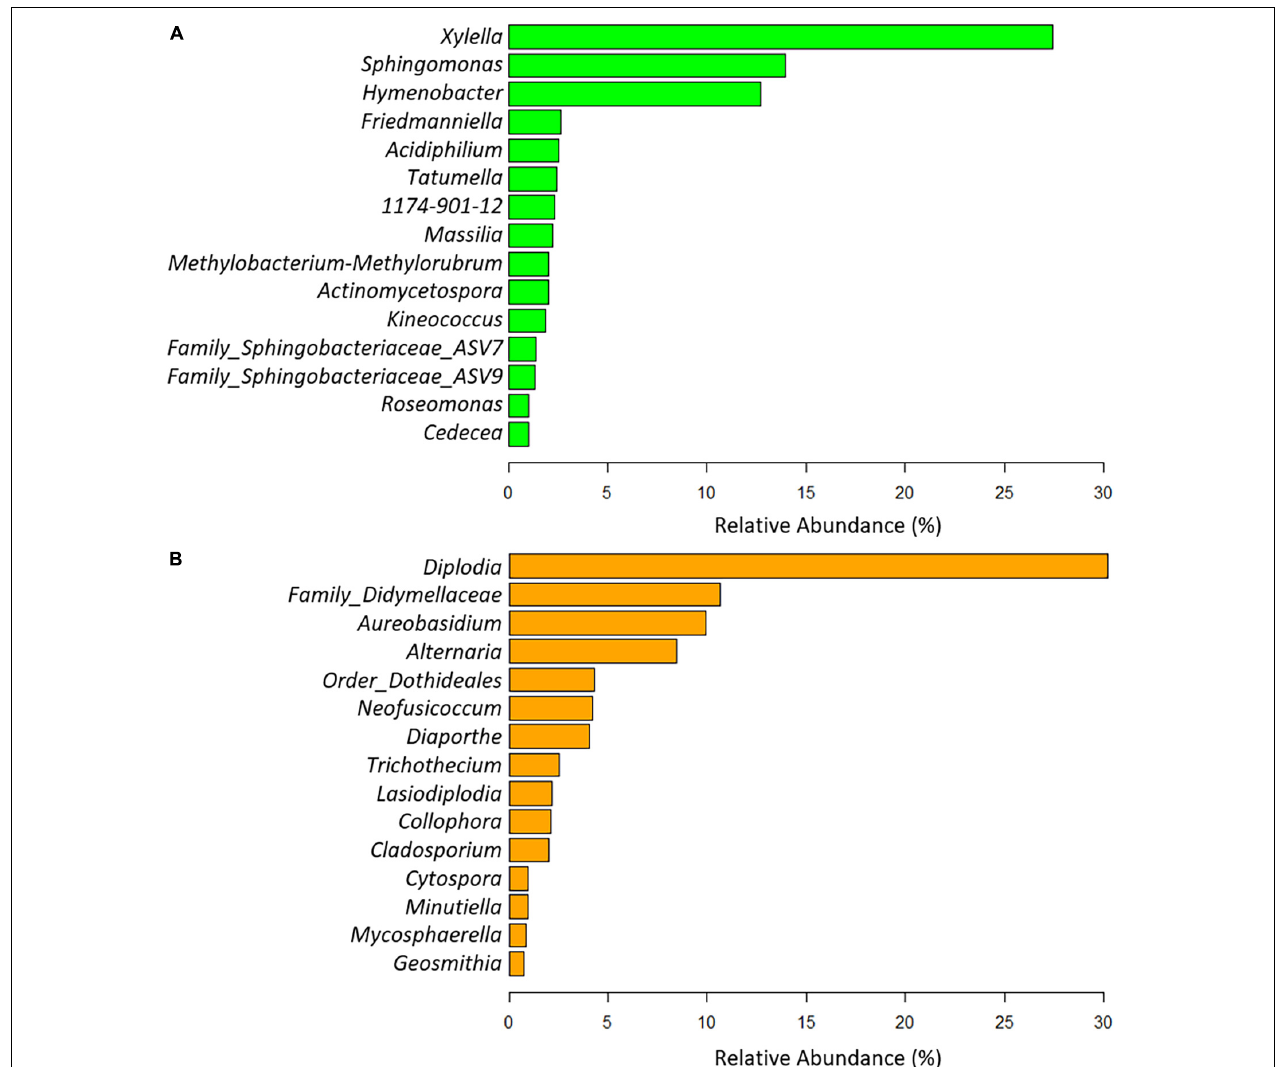
FIGURE 4 | Global relative bacterial (A) and fungal (B) taxa abundance at the genus level present in the xylem of almond trees for all experimental combinations evaluated in the